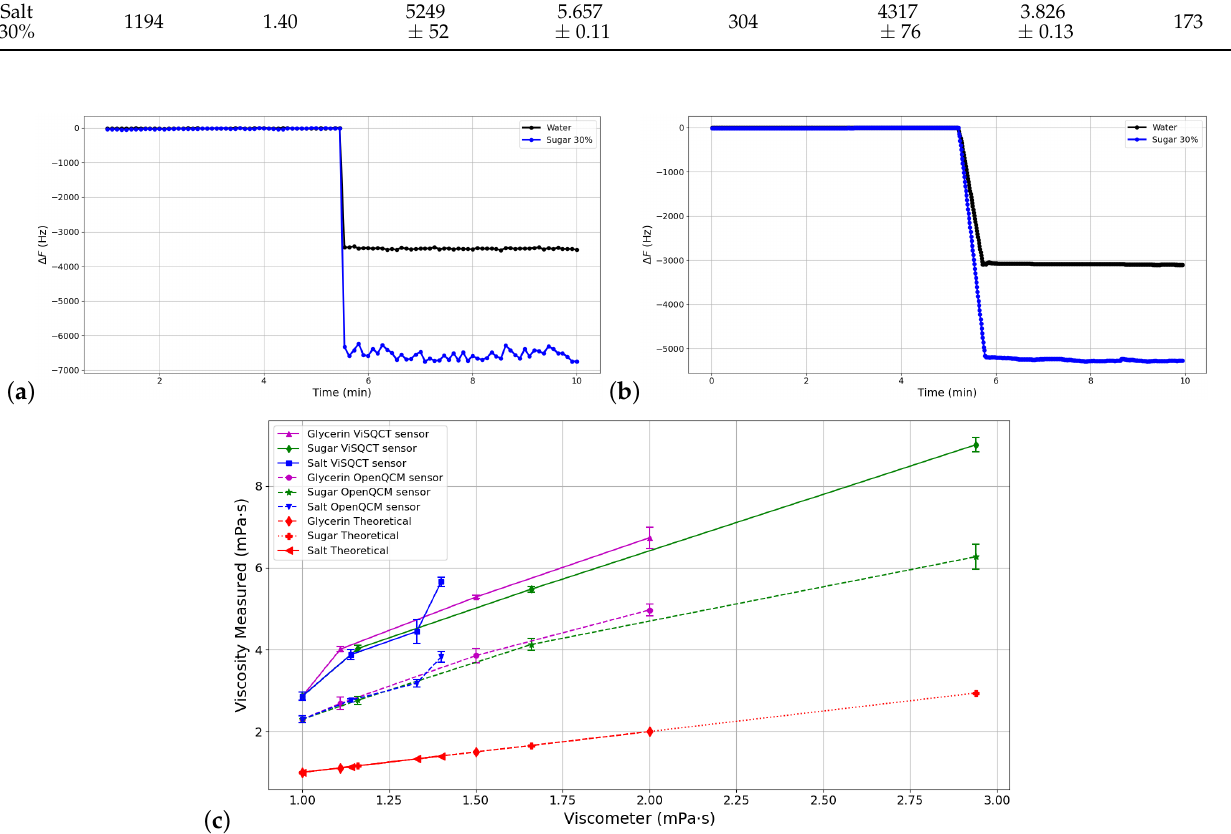
Figure 5. Resonance frequency measurement process for water and sugar 30% cases using: ( a ) ViSQCT sensor. ( b ) Open QCM R (cid:13) sensor. ( c ) Comparison of measured viscosities for different Glycerin, Sugar, and Salt dilutions in water using the two sensors and the rotational